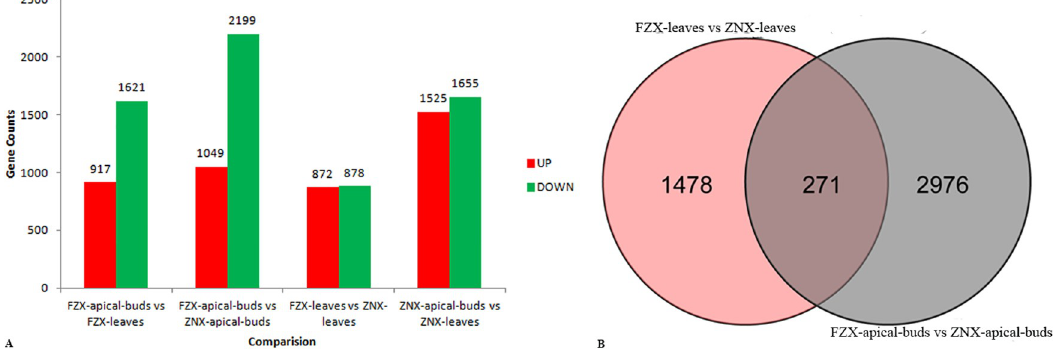
Fig 4. Differential gene expression profiles based on the library between vigorous and dwarf litchi samples. (A) The numbers of up- and down-regulated genes in comparisons of the FZX-apical-buds vs FZX-leaves, FZX-apical-buds vs ZNX-apical-buds, FZX- leaves vs ZNX-leaves, and ZNX-apical-buds vs ZNX-leaves litchi samples. (B) Venn diagram showing the comparison of differentially expressed genes between any two